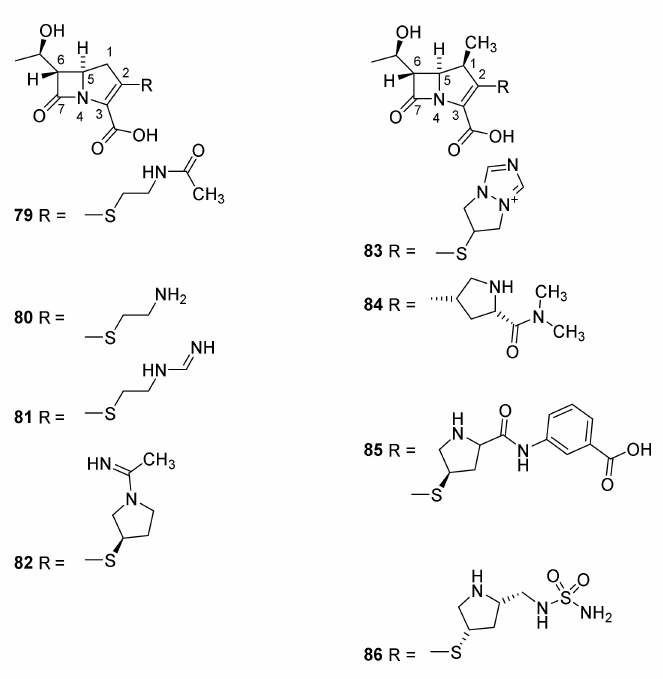
Figure 18. Carbapenems and 1-methylcarbapenems. Olivanic acid ( 79 ), thienamycin ( 80 ), imipenem ( 81 ), panipenem ( 82 ), biapenem ( 83 ), meropenem ( 84 ), ertapenem ( 85 ) and doripenem ( 86 )